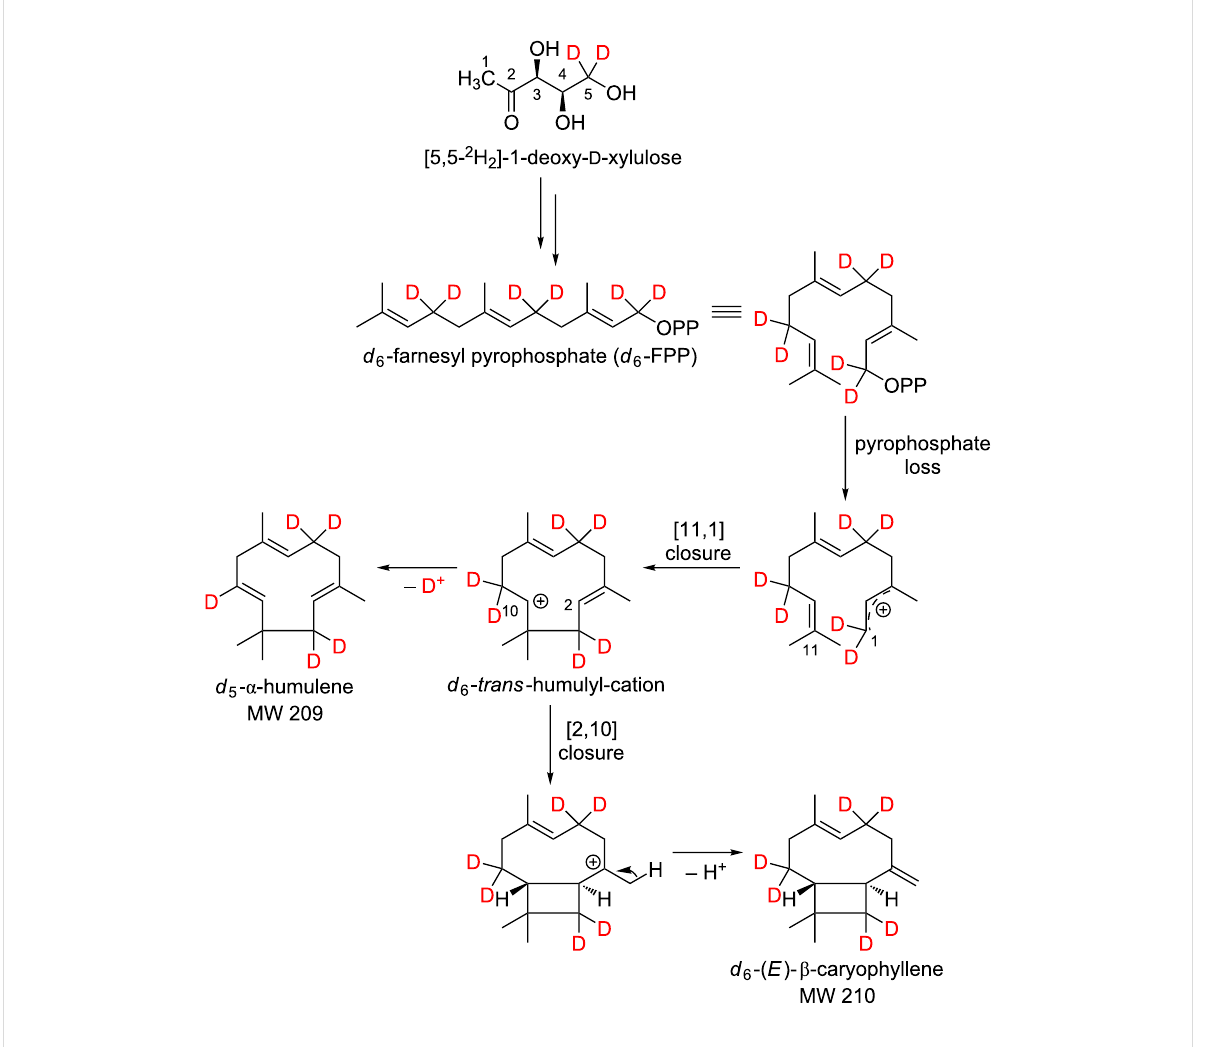
Scheme 8: Possible biosynthesis of d 6 -( E )- β -caryophyllene and d 5 - α -humulene starting from farnesyl pyrophosphate (FPP) after administration of [5,5- 2 H 2 ]-1-deoxy- ᴅ -xylulose ( d 2 -DOX) to isolated exocarp of grape berries (Lemberger